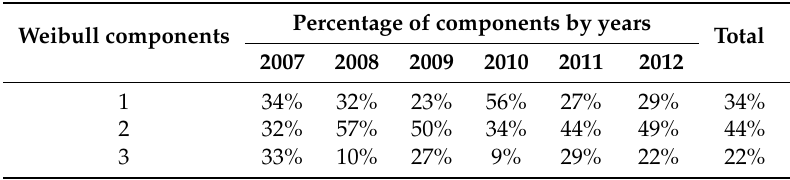
Table 3. Relative frequencies of the optimal number of Weibull components (BIC approach) using aggregated wind power generation data.